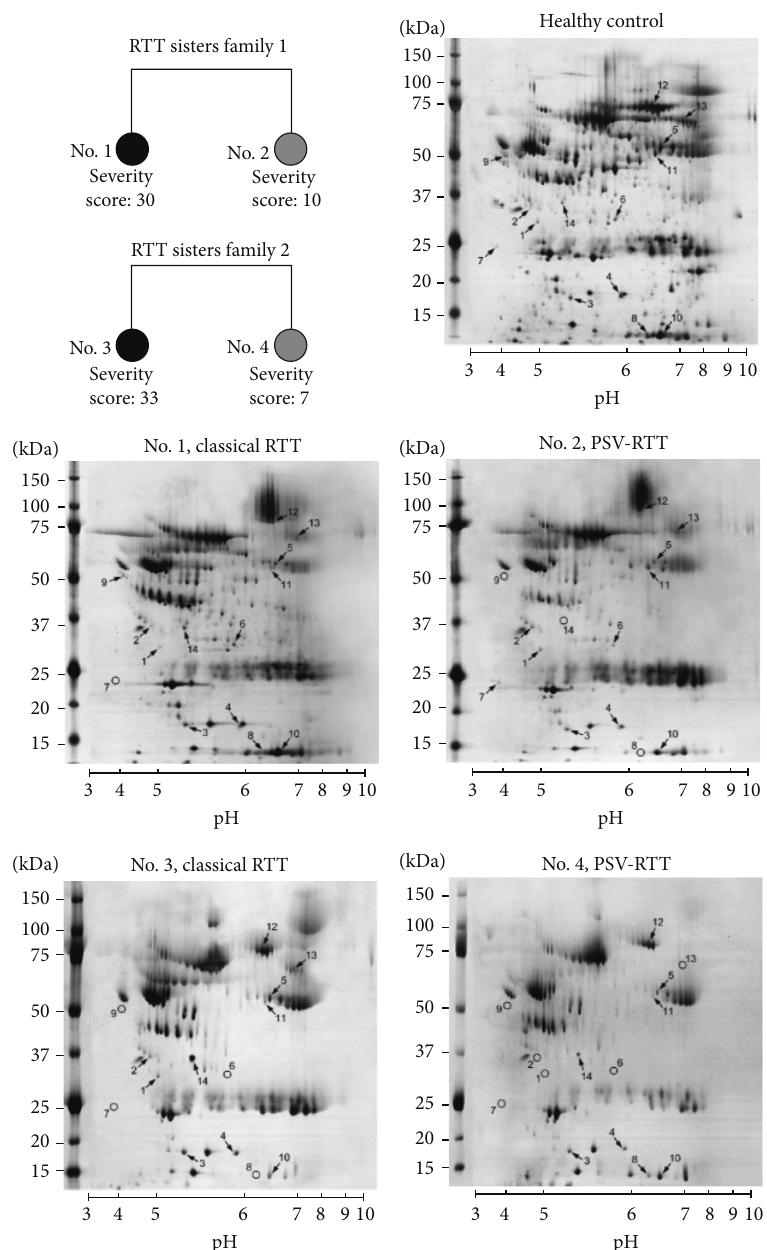
Figure 1: In the pedigrees the two RTT sisters families are represented by grey circles (milder variant = preserved speech variant, PSV-RTT) or black circles (more severe phenotype = classical RTT) with their respective clinical scores as derived by the approbation of phenotypical severity scale [9]. In the 2-DE maps typical control plasma proteome (healthy control), RTT sisters Family 1 (no. 1, no. 2) and RTT sisters Family 2 (no. 3, no. 4) are shown. Arrows indicate the protein spots with significant variations in their major or minor relative volume; circles are used to indicate the absence of the spots (i.e., qualitative